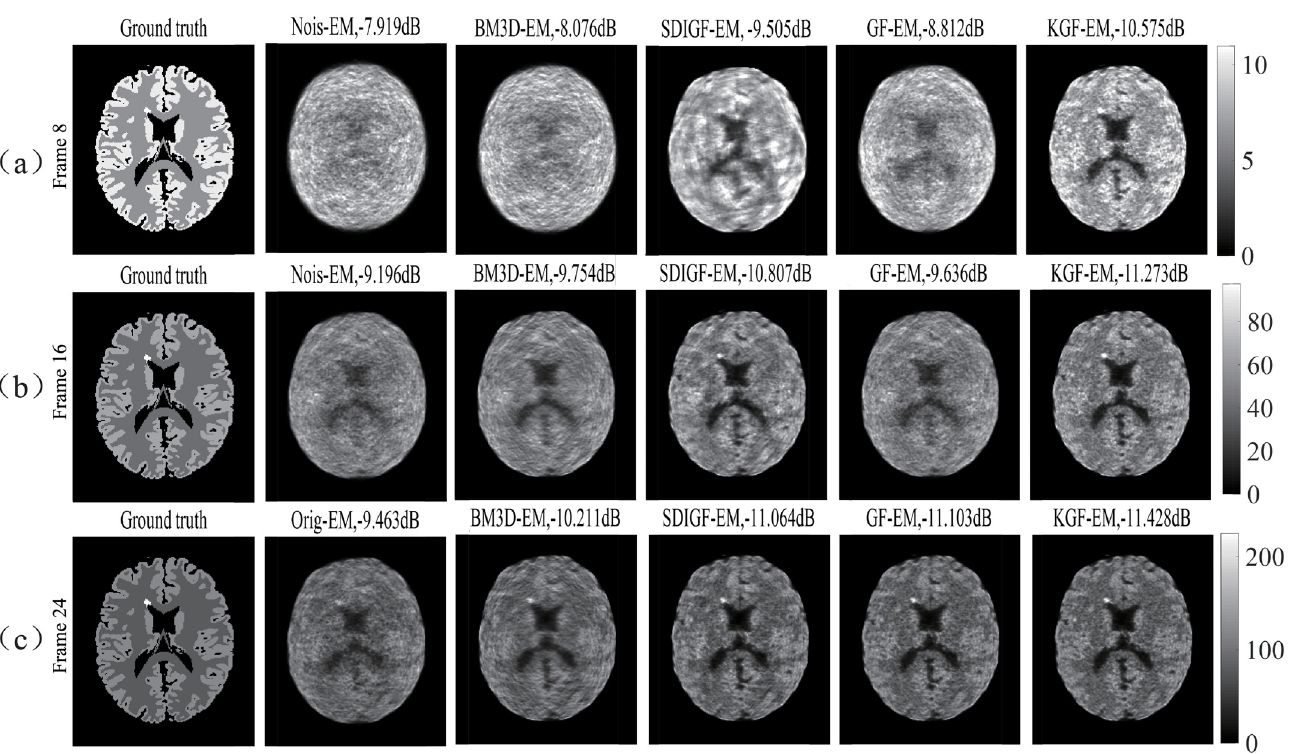
Fig 4. MLEM reconstructed images from the corresponding sinograms shown in Fig 2. (a) Frame 8 (count = 68k), (b) Frame 16 (count = 492k), (c) Frame 24 (count = 914k). Ground truth column: images from noiseless sinograms, Nois column: images from noisy sinograms, other columns: images from sinograms denoised by respective methods. The dB values are MSEs of reconstructed